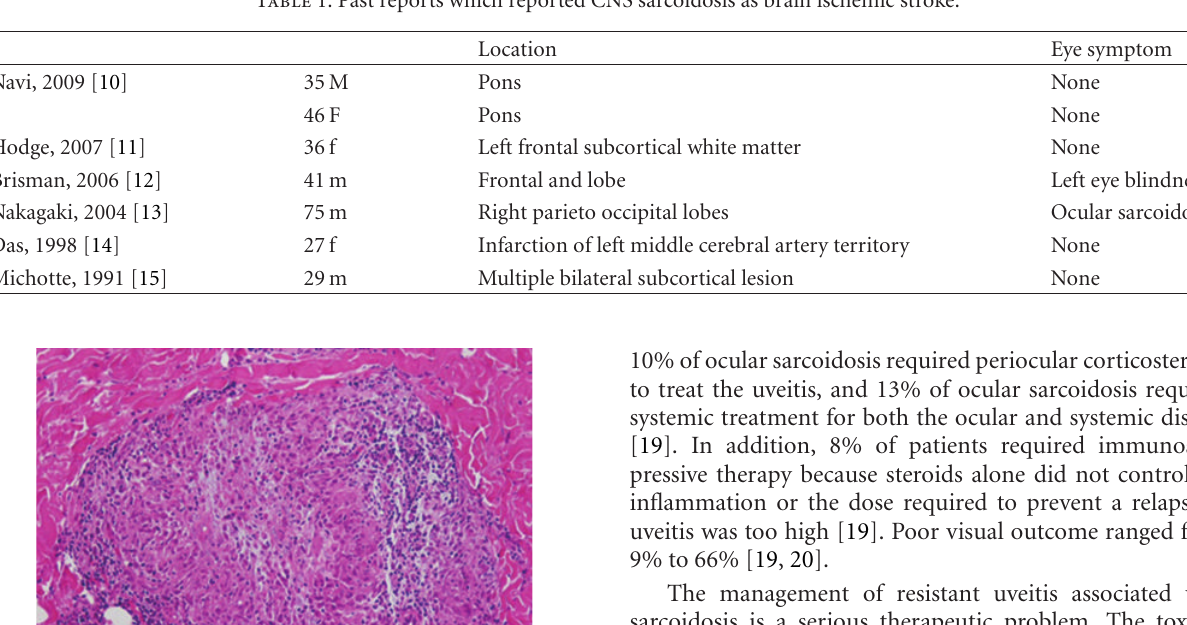
Figure 2: Images of the brain of a patient with an infarct in the medulla oblongata. (a) Left medulla oblongata encephalomalacia on axial T2-fluid-attenuated inversion image (arrow head). (b) Di ff usion-weighted (TTt) image showing restricted di ff usion in the left medulla oblongata (arrowhead). Table 1: Past reports which reported CNS sarcoidosis as brain ischemic stroke.